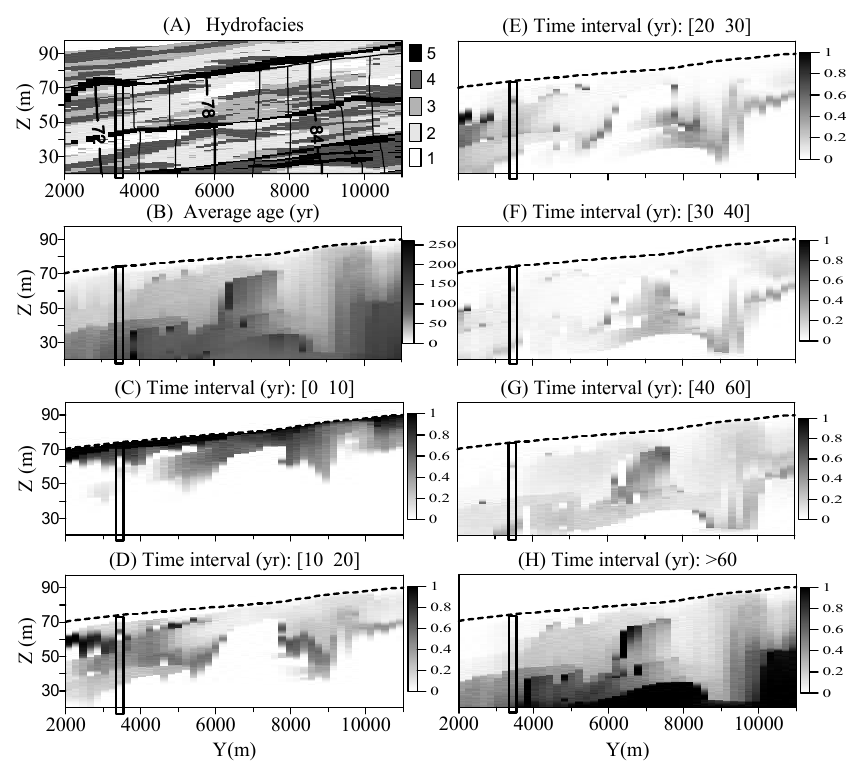
Figure 5. Sensitivity Maps for the vertical slice ( X = 3600 m) outside of the IVF. Legends are the same as Figure 4. The thick, small rectangle represents the column used in Figures 6B and 7B.